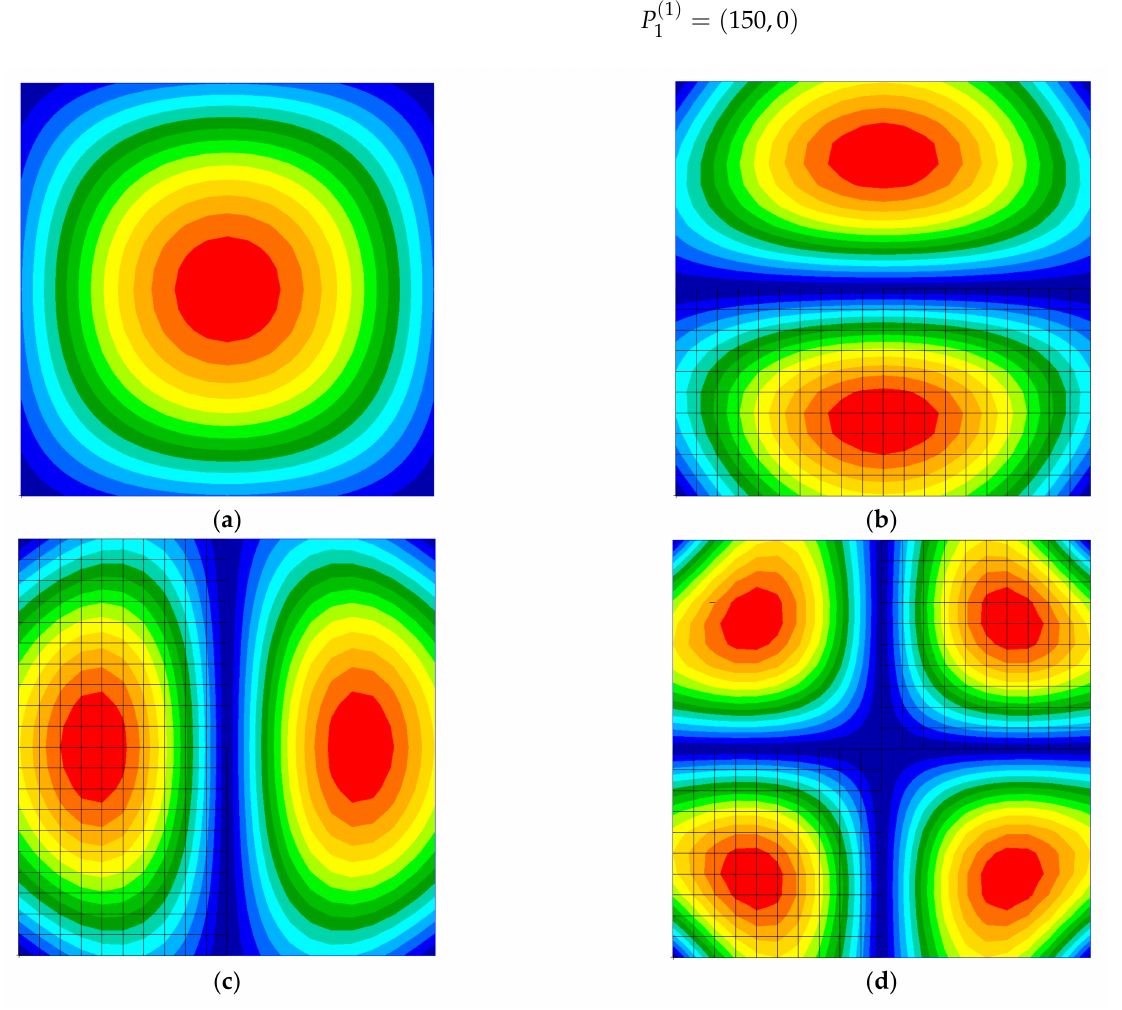
Figure 11. The first four modes of the panel with elastically supported boundaries on four sides: ( a ) the first mode (53.28 Hz); ( b ) the second mode (115.27 Hz); ( c ) the third mode (115.27 Hz); ( d ) the fourth mode (167.23